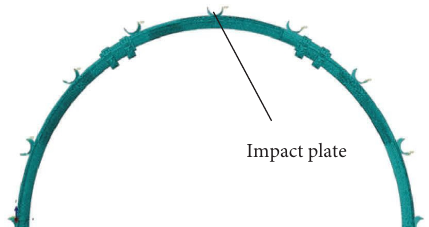
Figure 6: Calculation model fgure of U -shaped steel bracket.